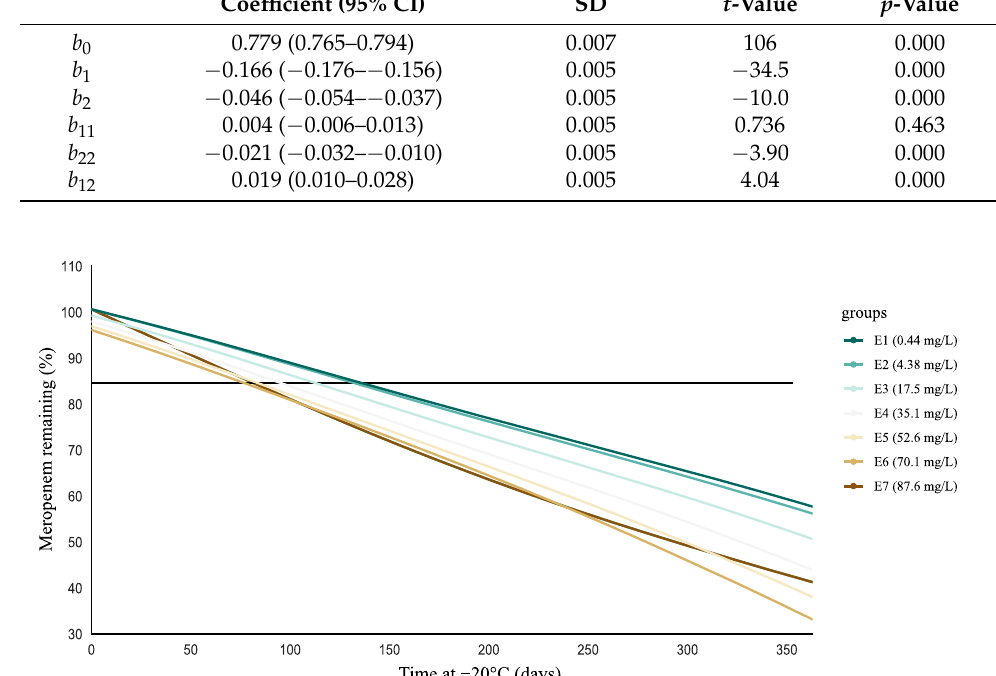
Table 3. Polynomial regression coefficients. The coefficients are reported with the standard devia- tion (SD) and 95% confidence interval (CI). Two-sided t -tests were computed to evaluate the null hypothesis that the coefficient is equal to zero. The results suggest that the null hypothesis should be rejected ( p < 0.05) for all predictors, except for the second-order effect of storage duration, which was found to be insignificant ( p > 0.05).